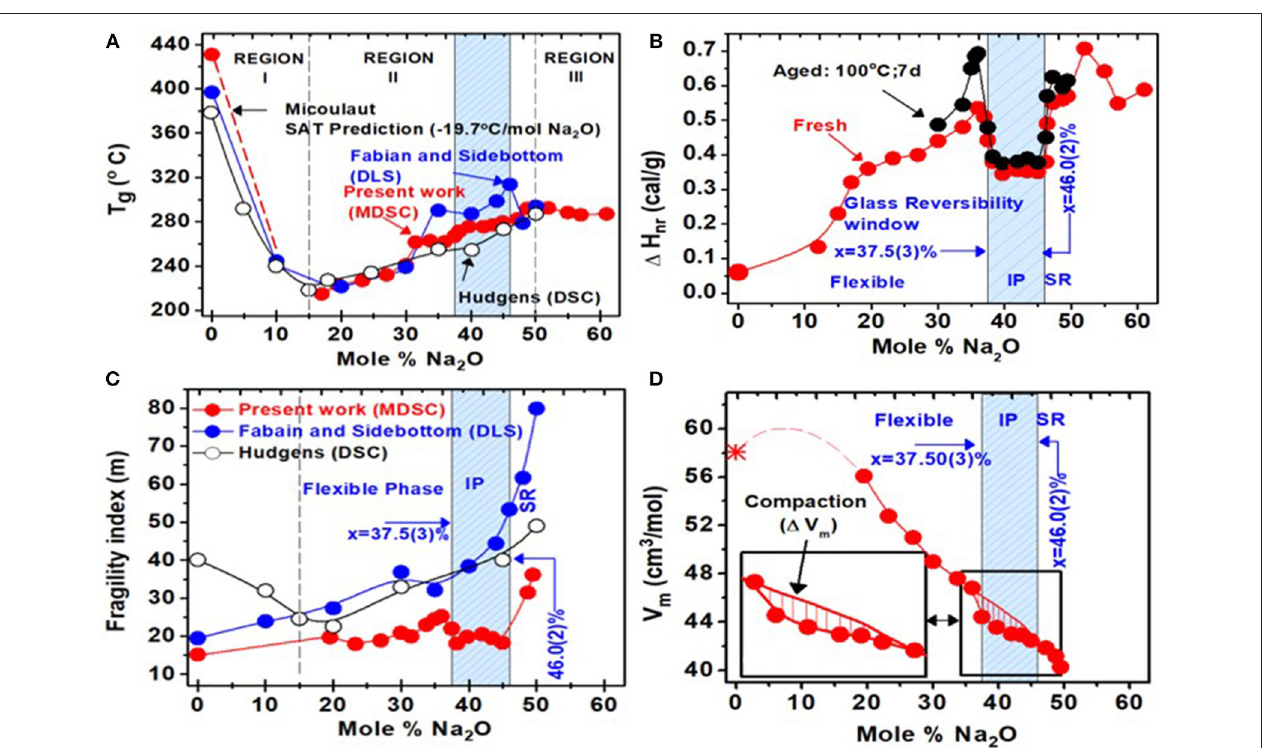
FIGURE 6 | Calorimetric results on sodium phosphate glasses obtained from present work and two earlier reports (Hudgens, 1994; Fabian and Sidebottom, 2009). Compositional trends in (A) T g (x) (B) in the non-reversing enthalpy of relaxation, 1 H nr (x), (C) melt fragility index m(x), and (D) molar volumes V m (x). The light blue panel represents the glass composition range across which a glass reversibility window and a melt fragility window are observed, and it is identified with the isostatically rigid intermediate phase. Compositions at x < 37.5(3)% are in the flexible phase, while those at x > 46.0(2)% are in the stressed rigid phase. At x > 50%, glasses steadily fragment with the decoupling of pyrophosphate units. In the intermediate phase, molar volumes show a local minimum consistent with the compacted nature of networks formed therein. The composition x = 37.5% represents the rigidity elastic phase transition in these glasses, and it coincides with the percolation of rigidity in the Sidebottom coarse graining model (D. L. Sidebottom and Schnell 2013) of these glasses.